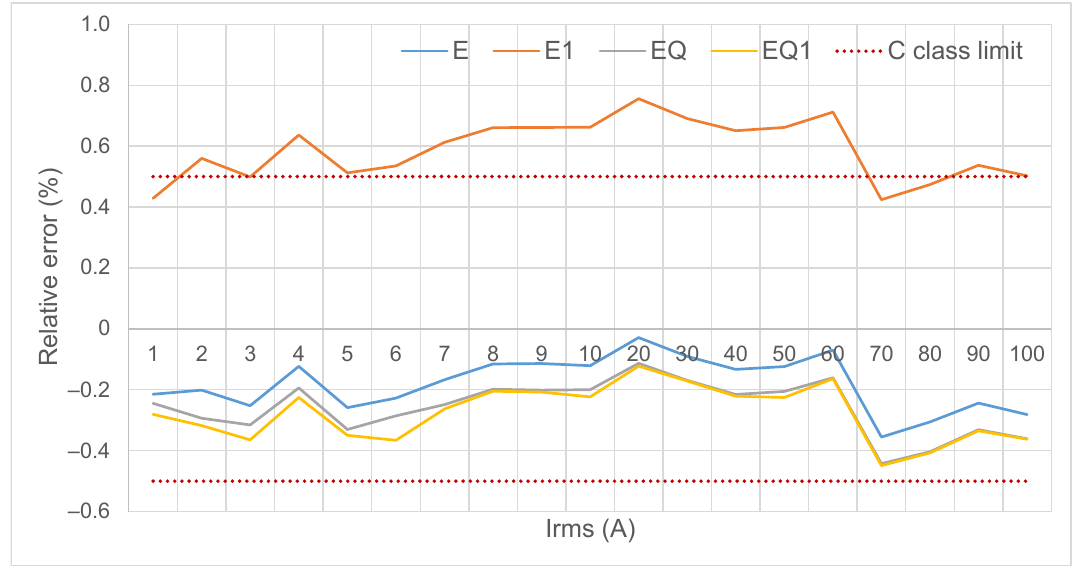
Figure 8. Sinusoidal tests results for 1–100% ADC full